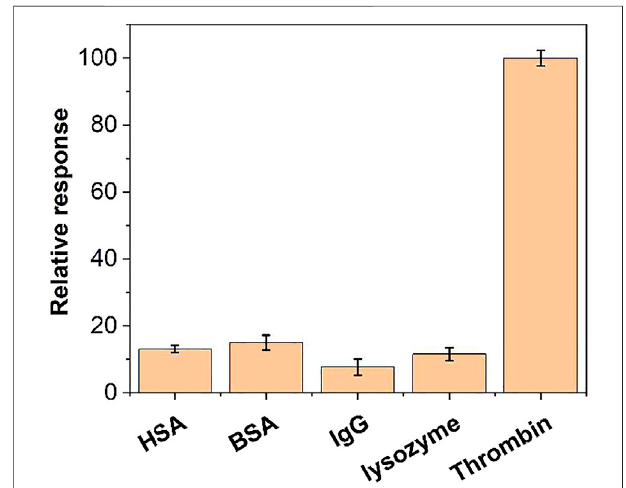
FIGURE 10 | The relative response of the aptamer sensor towards 10 nM thrombin, BSA, IgG, lysozyme and